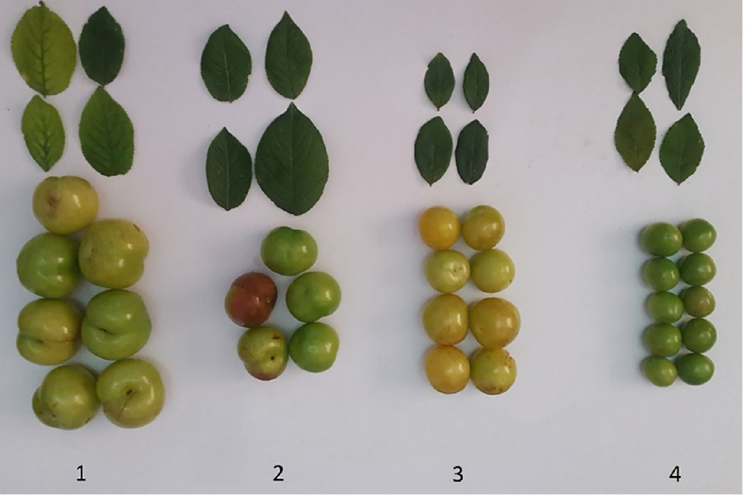
Fig 1. The leaves and fruits of three greengage genotypes [ Prunus domestica (subsp. italica var. claudiana .)] with local names Gavali (1), Ghandi (2) and Shahryari (3) and a myrobalan (4) plum (prunus ceracifera) with local name of